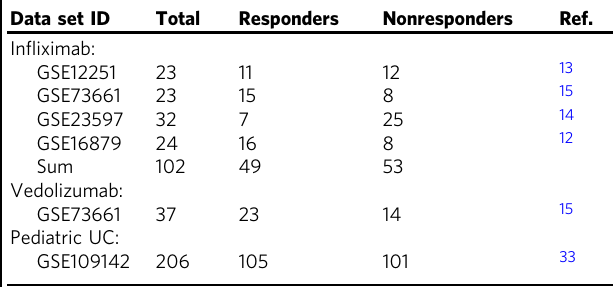
Table 1 Publicly available human data sets used in this